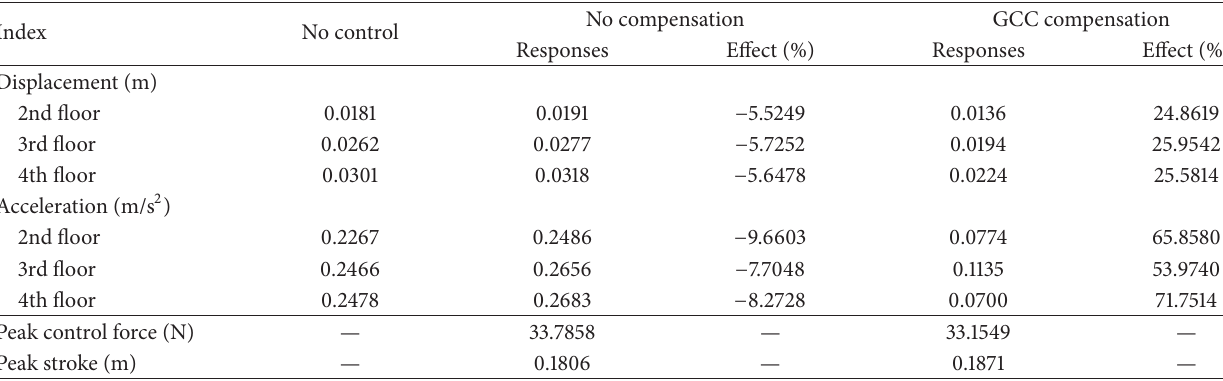
Table 7: Control effectiveness of structural responses